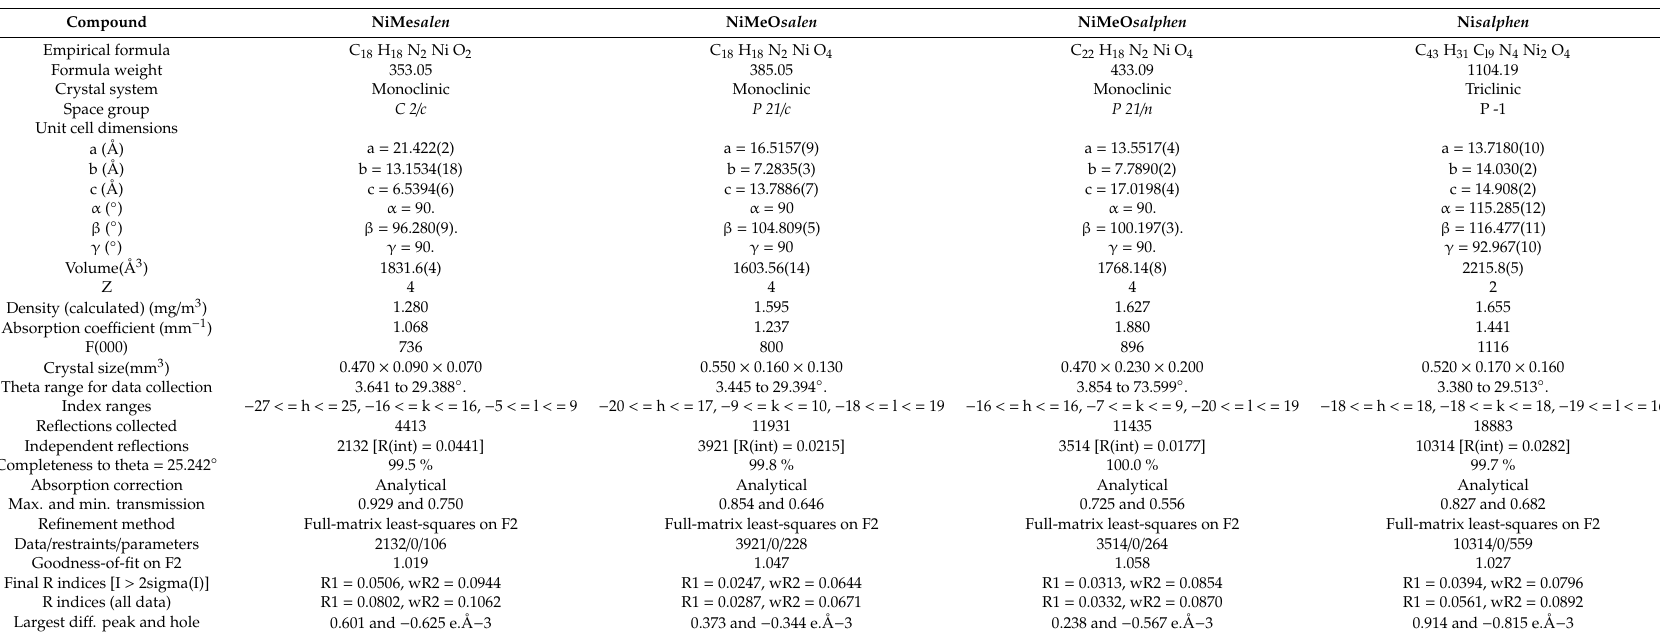
Table 1. X-ray di ff raction data collection and refinement parameters for the compounds NiMe salen, NiMeO salen, NiMeO salphen, and Ni salphen.